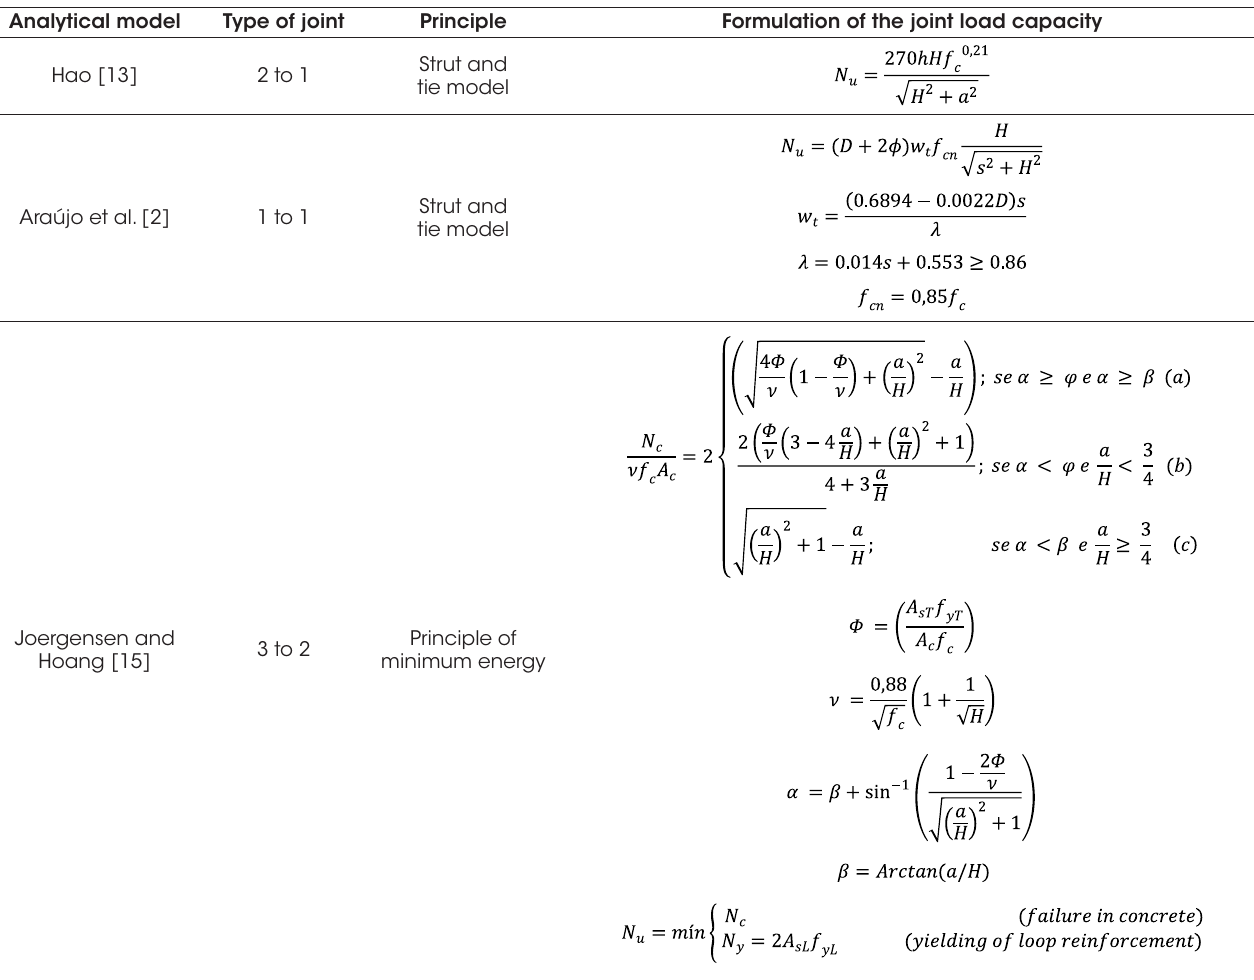
Ultimate force of the elements, in